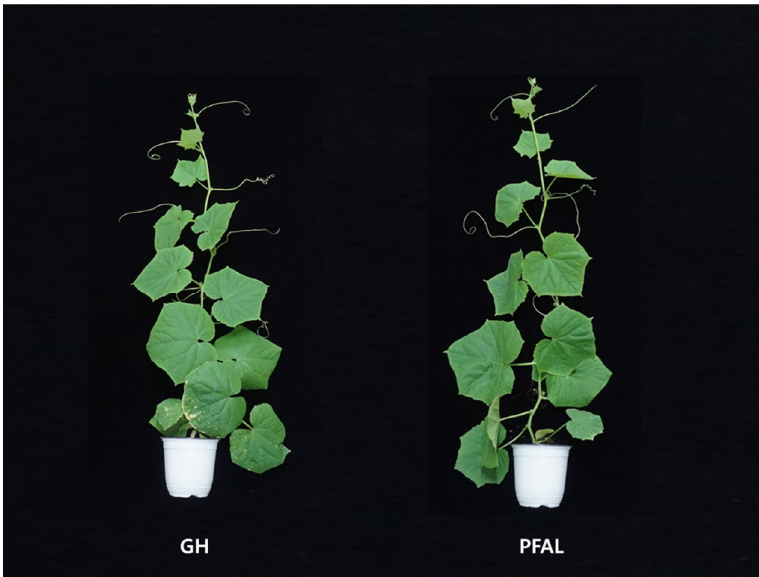
Figure 8. Grafted cucumber seedlings after transplanting as affected by the cultivation of scions and rootstocks in a PFAL and GH. Table 7. Growth of grafted cucumber seedlings after transplanting as affected by the cultivation of scions and rootstocks in a PFAL and GH ( n = 7, R = 3). Treatments